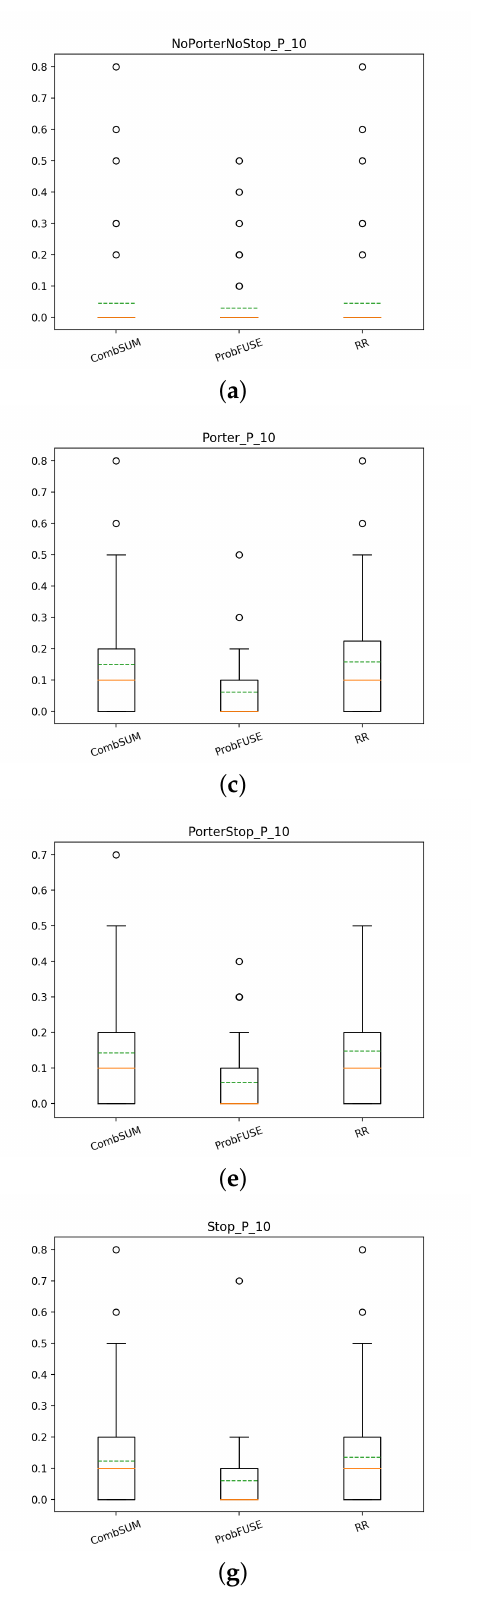
Figure 13. T1: box plots of P@10 of the fusion methods: ( a ) NoPorterNoStop fusions of the runs, ( b ) NoPorterNoStop+QR+RF fusions of the runs, ( c ) Porter fusions of the runs, ( d ) Porter+QE+RF fusions of the runs, ( e ) PorterStop fusions of the runs, ( f ) PorterStop+QE+RF fusions of the runs, ( g ) Stop fusions of the runs, ( h ) Stop+QE+RF fusions of the